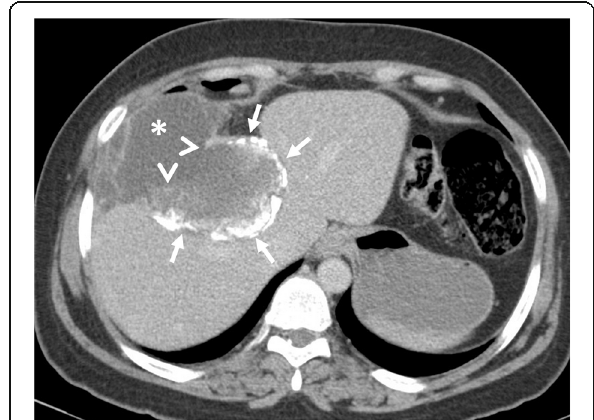
department with right upper quadrant pain. Axial contrast-enhanced CT image demonstrates calcified hydatid cyst (arrows) rupture through the perihepatic space. A fluid collection containing cyst content (asterisks) was found adjacent to the hepatic capsule due to the loss of integrity of the cyst wall (arrowheads). Surgical findings confirmed the rupture of the hydatid cyst into the perihepatic space